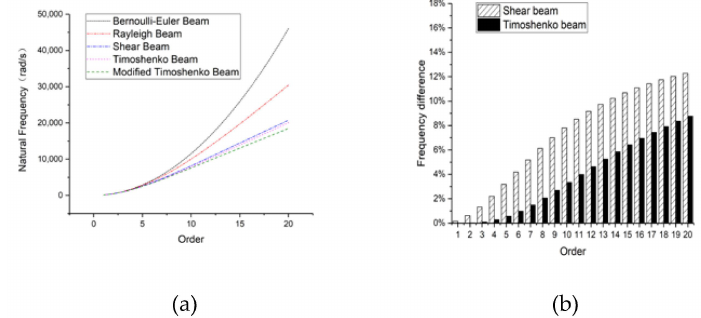
Figure 4. Natural frequencies of the 8-m-long beam: ( a ) overall frequency curve and ( b ) frequency di ff erence compared with a modified Timoshenko beam.